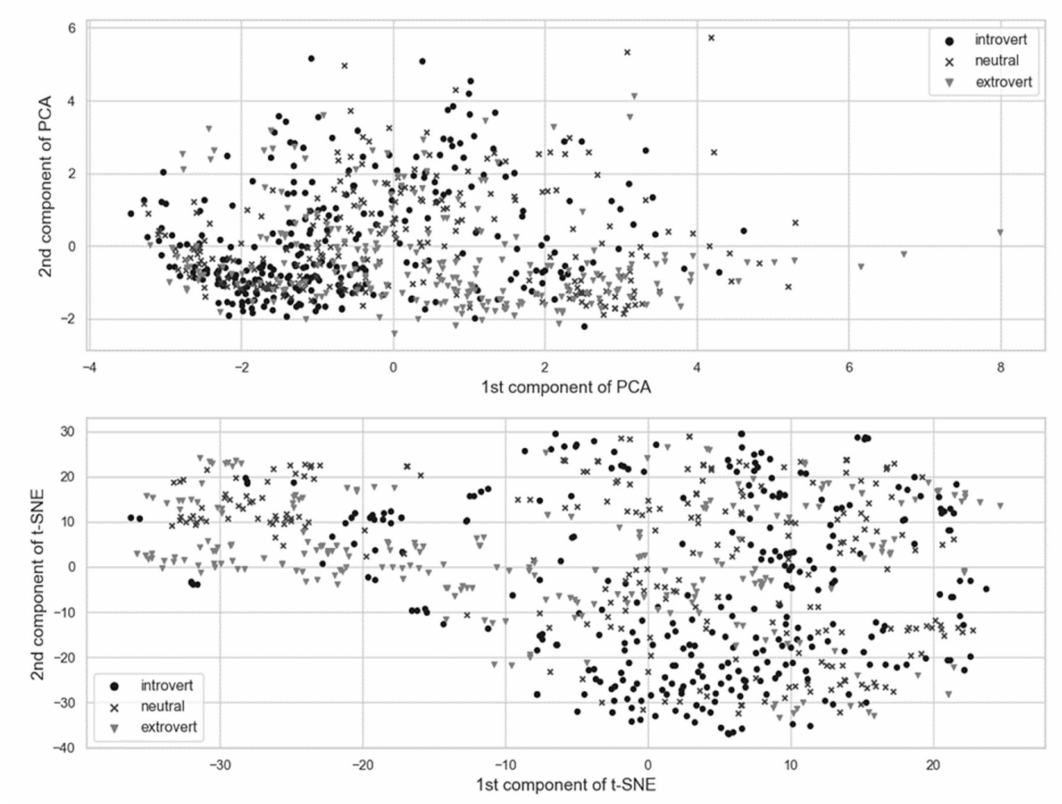
Figure11. Visualizationofthelatentspacegeneratedbythe45-dimensionalparameterizationemploying parameters calculated by the variational autoencoder trained on both the S and the ED